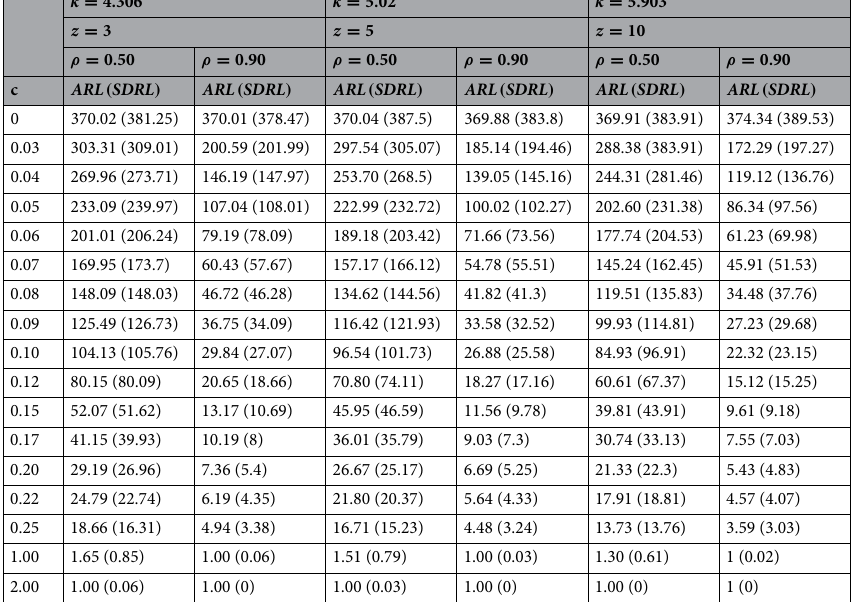
Table 4. ARLs of EWMA-REMA control chart when ARL 0 = 370, n = 5, (cid:31) = 0.20 .